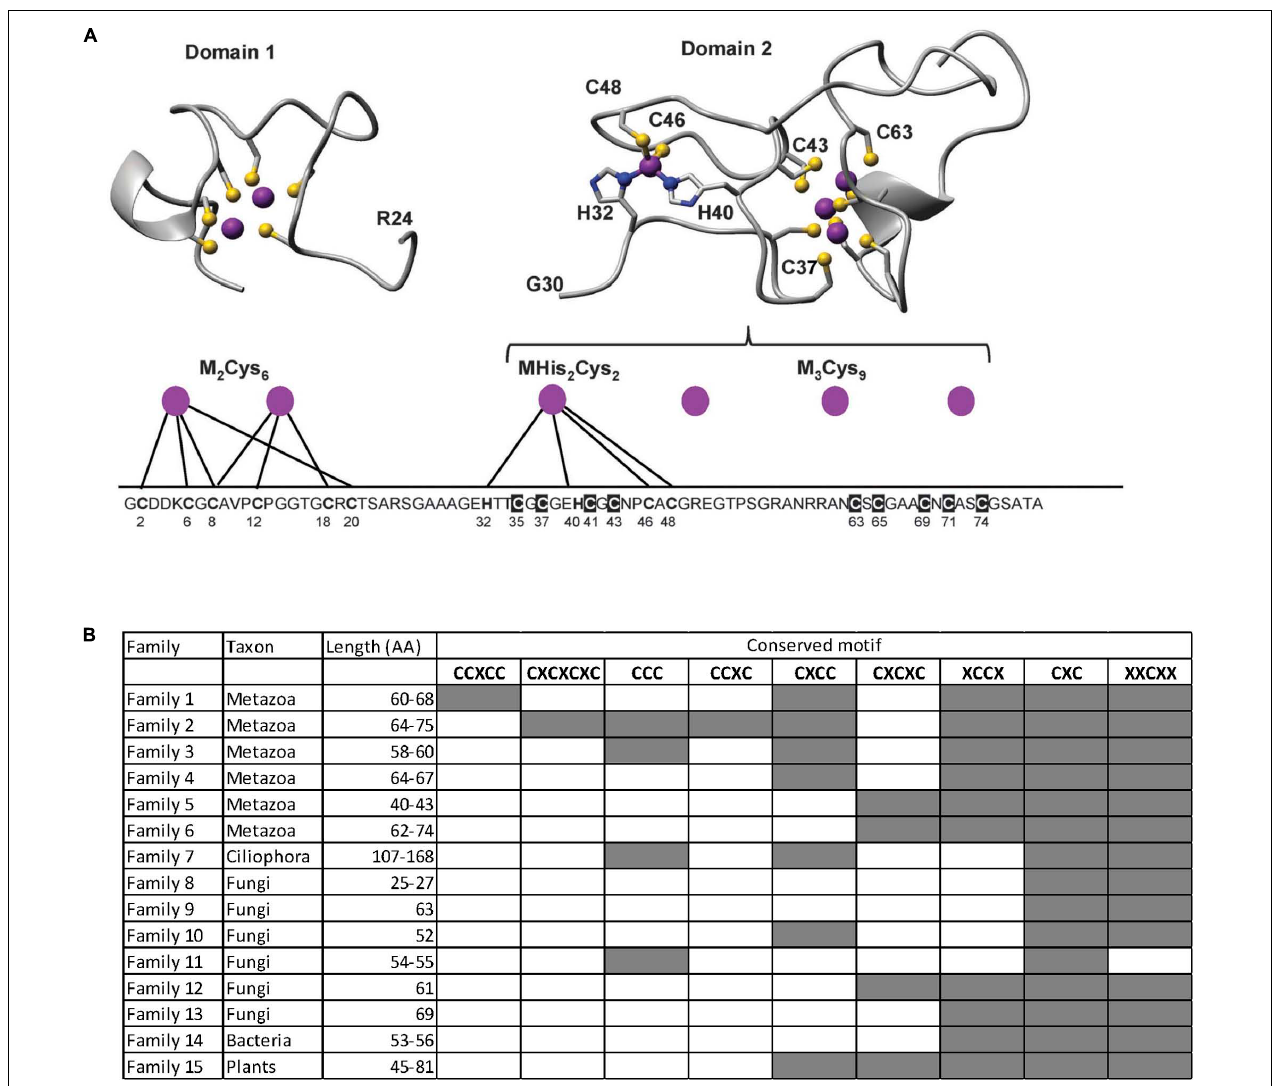
FIGURE 1 | (A) Tertiary structure and active sites for metal binding in Type 4 plant metallothioneins from wheat. Adapted from Figure 9 in Leszczyszyn et al. (2013). (B) Occurrence of cysteine-rich motifs in the different metallothionein (MT) families described to date. Adapted from Figure 1D in Ziller et al. (2017). License to